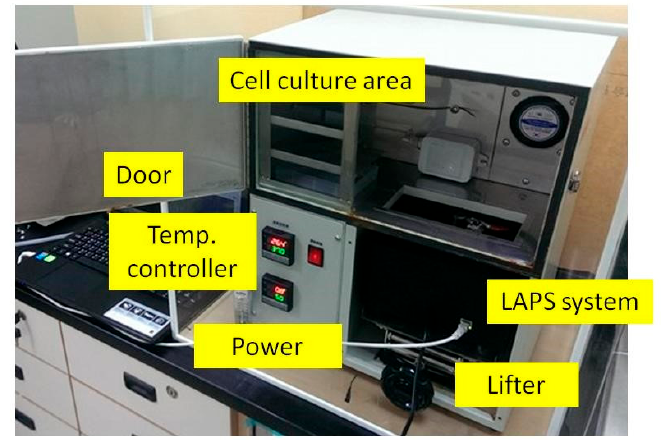
Figure 2. Self-designed incubator to embedded LAPS measurement system and sensor